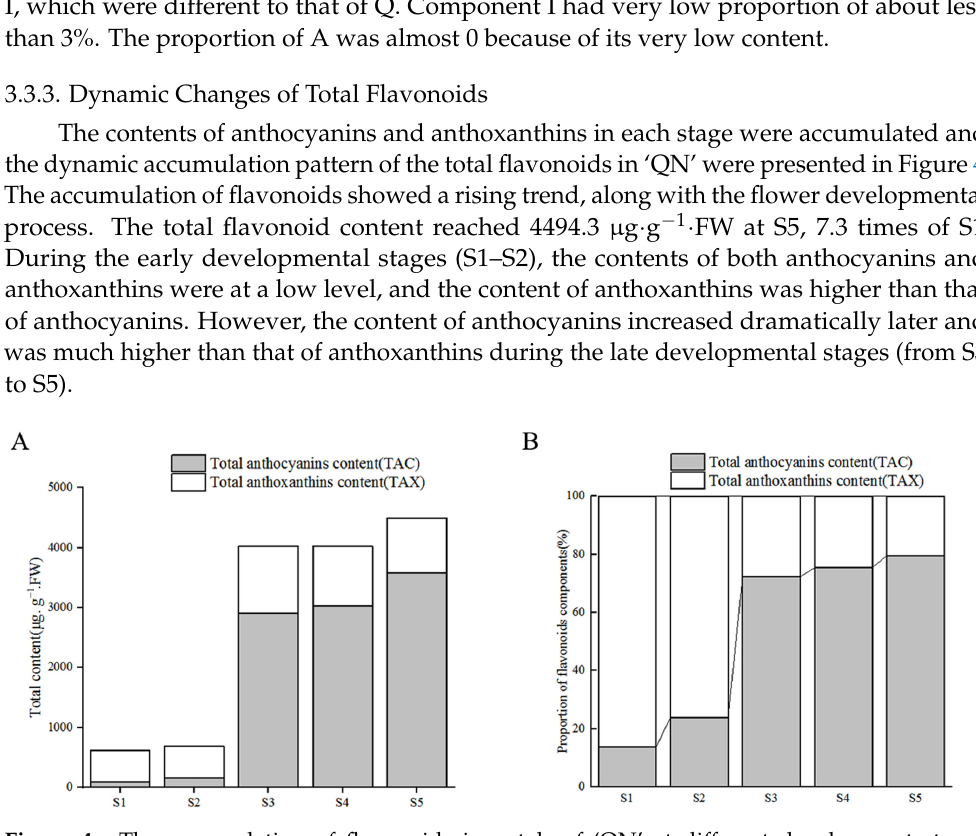
Figure 4. The accumulation of flavonoids in petals of ‘QN’ at different development stages. ( A ) Content of flavonoids. ( B ) Percentage of